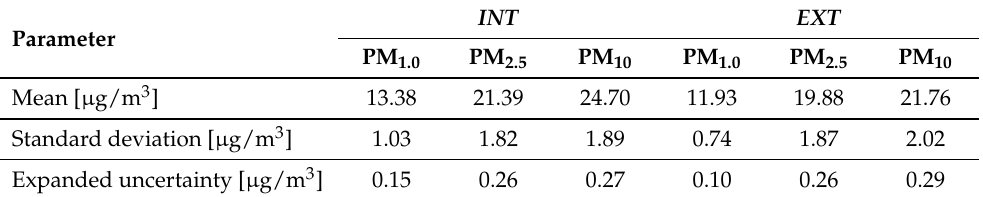
Figure 8. PM 10 data from both sensors: ( a ) time series; ( b ) box plot; ( c ) histogram; ( d ) qq plot. Table 2. Statistical data determined for two PMS5003 sensors